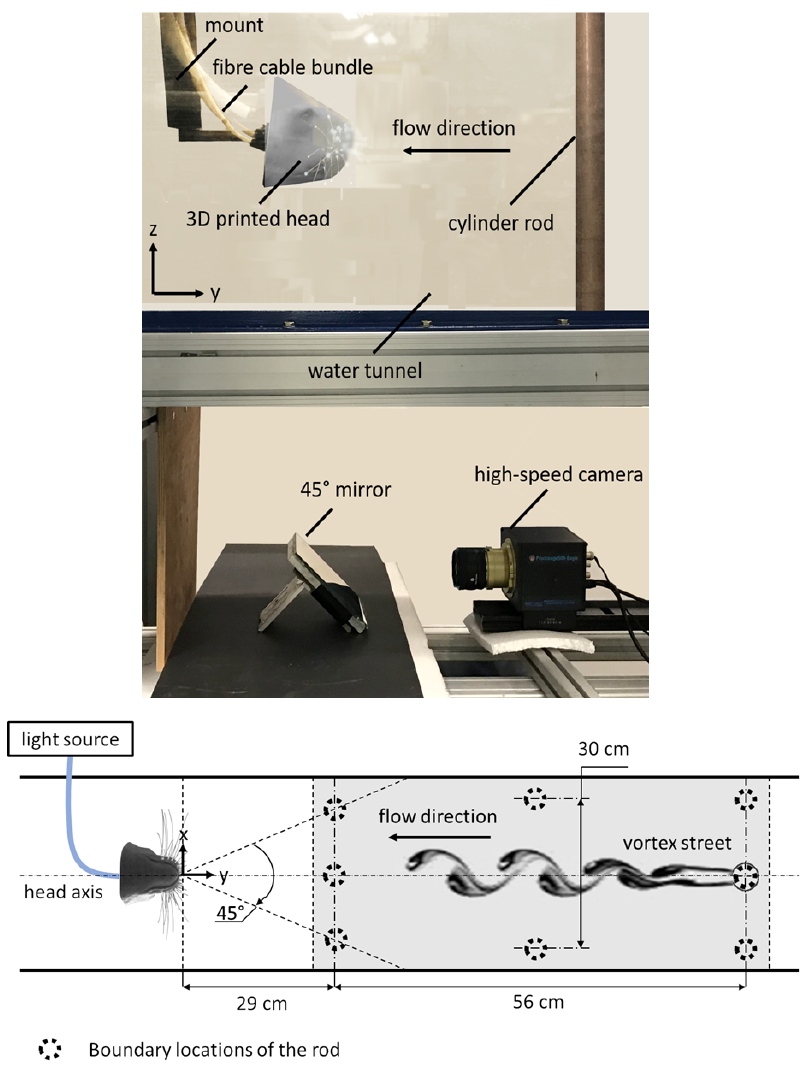
Figure 2. Experimental set-up of the artificial head and the flow disturbance inside the water tunnel. The side view ( top ) shows the optical setup of a high-speed camera underneath the test section and a 45 ◦ mirror that are used to monitor the motion of the illuminated whisker tips. The plan view ( bottom ) shows the boundary locations of the cylinder during different tests. The recorded data of the whiskers’ vibrations due to the existence of the cylinder at different locations are used for training the learning models. The origin of the coordinate system is placed at the intersection of the head axis with its frontal